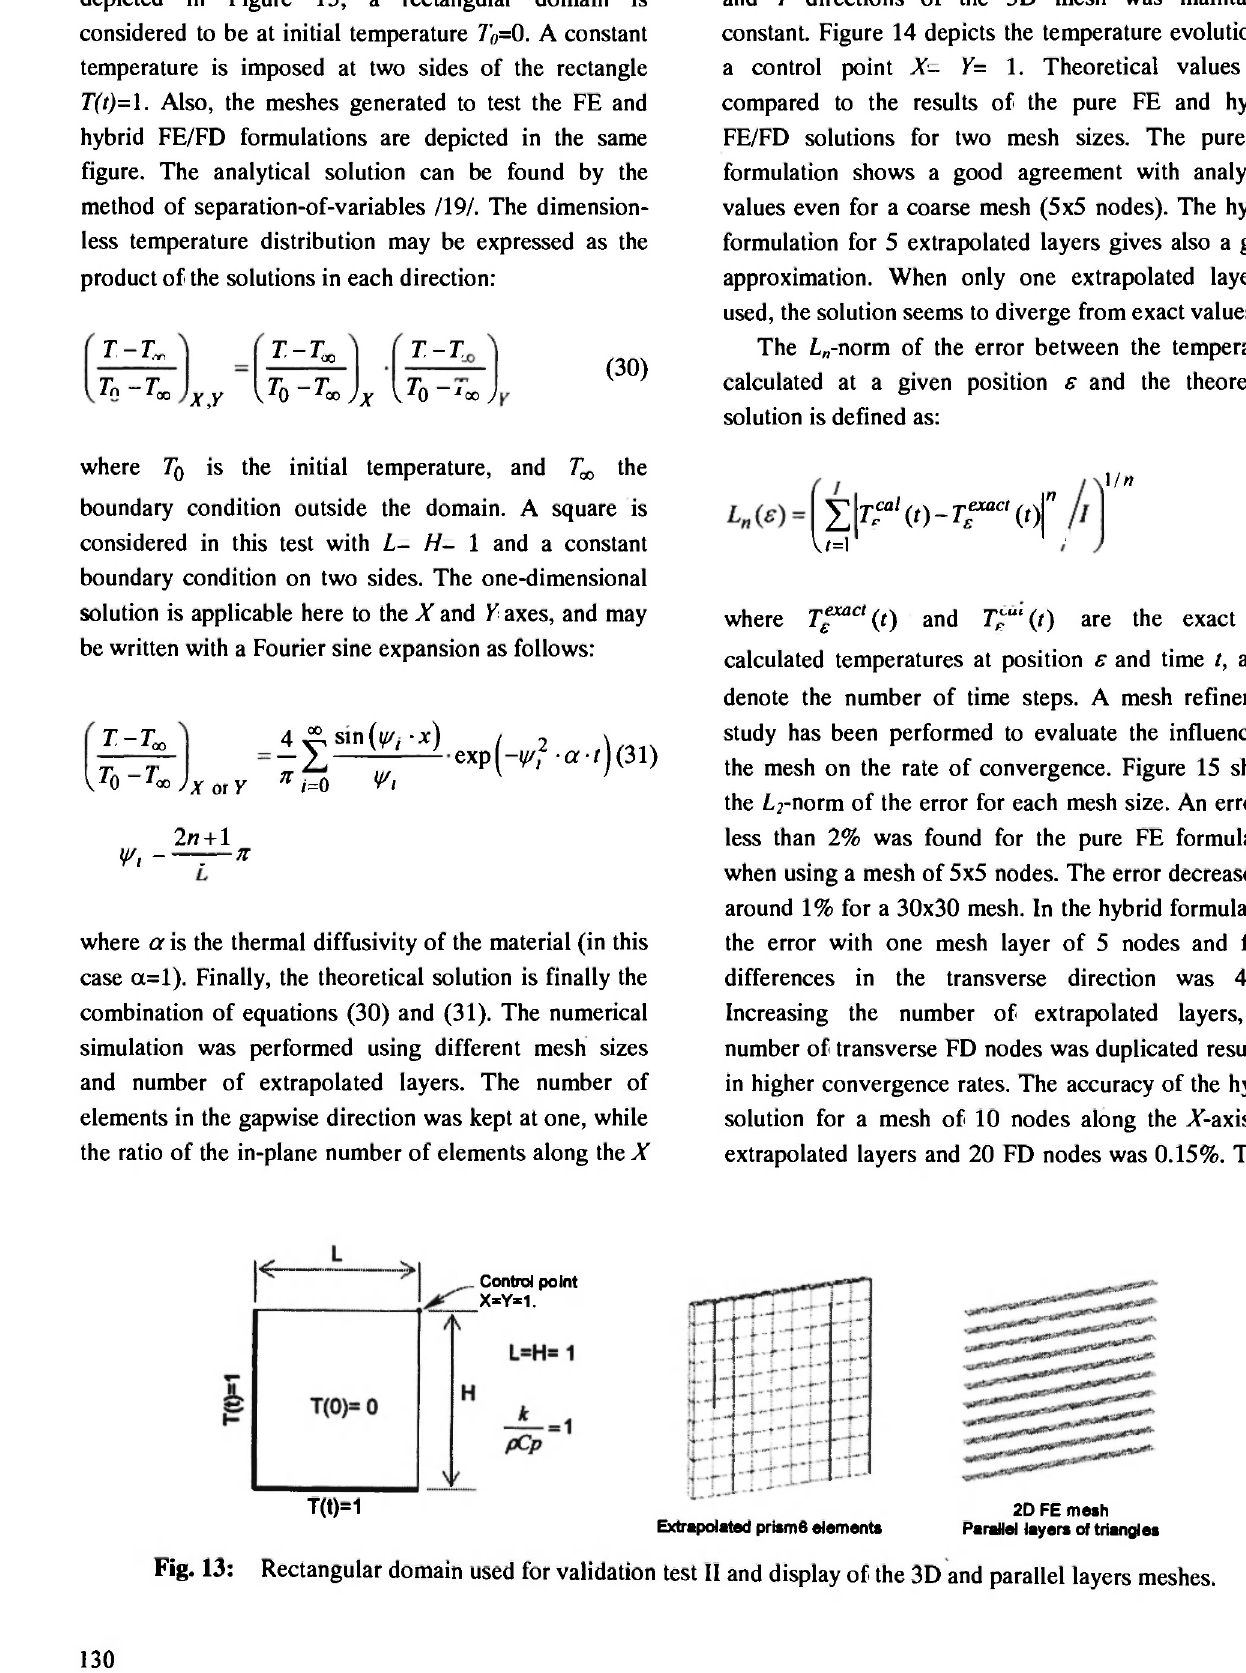
Rectangular domain used for validation test II and display of the 3D and parallel layers